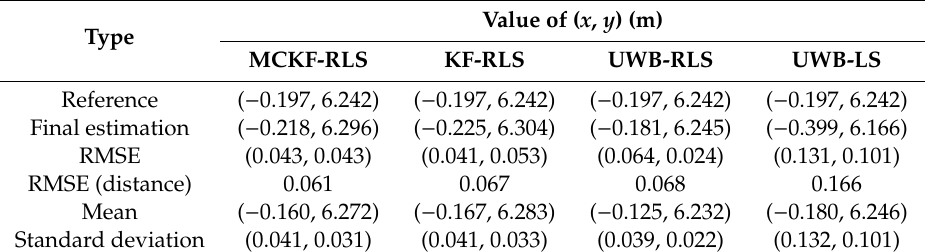
Table 3. Coordinate of the new anchor.